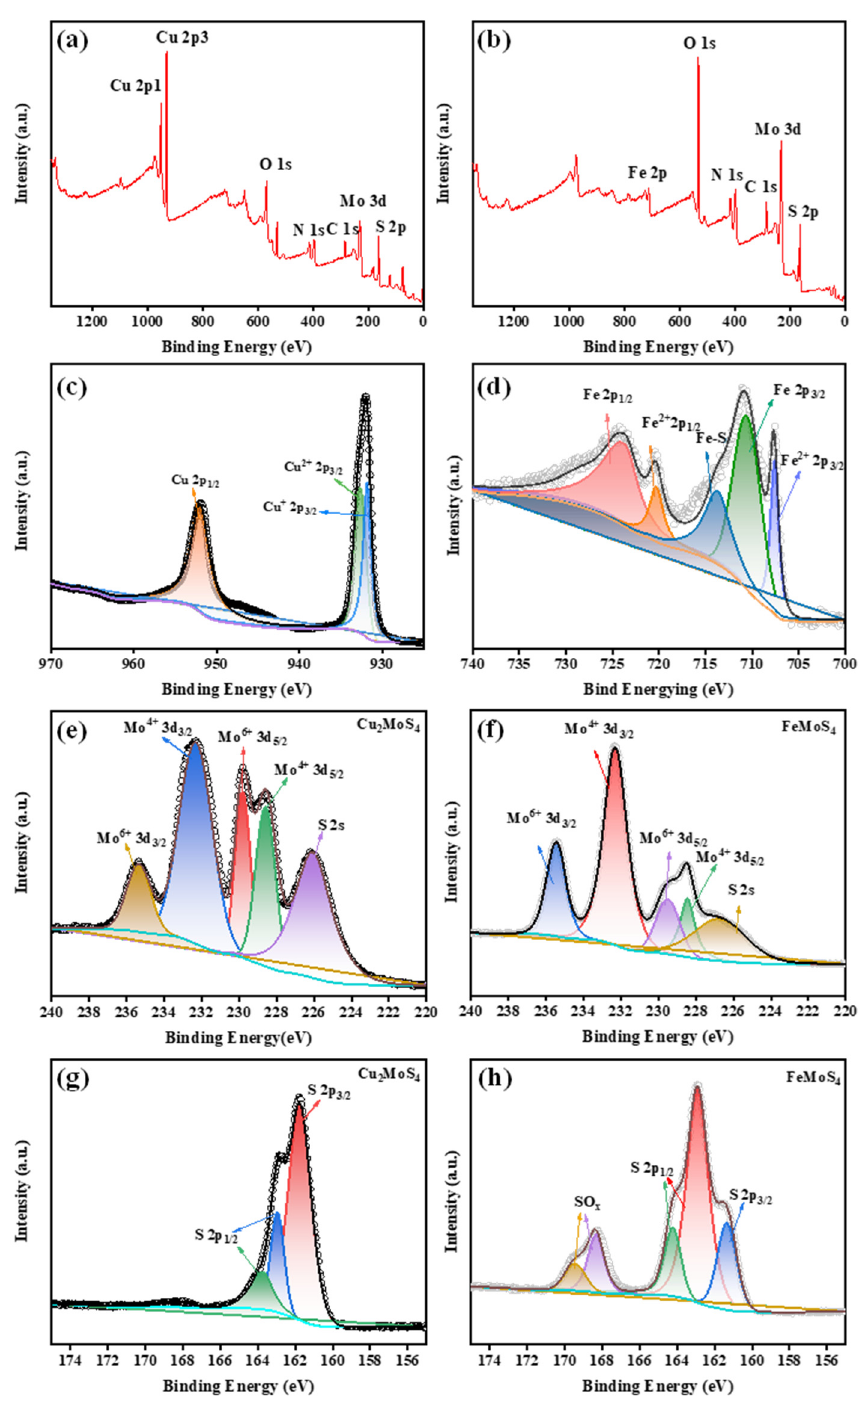
Figure 3. XPS spectra of as-prepared Cu 2 MoS 4 nanostructures: ( a ) survey spectra; core level spectra of ( c ) Cu 2p, ( e ) Mo 3d, ( g ) S 2p and FeMoS 4 nanostructures: ( b ) survey spectra; core level spectra of ( d ) Fe 2p, ( f ) Mo 3d, ( h ) S 2p.